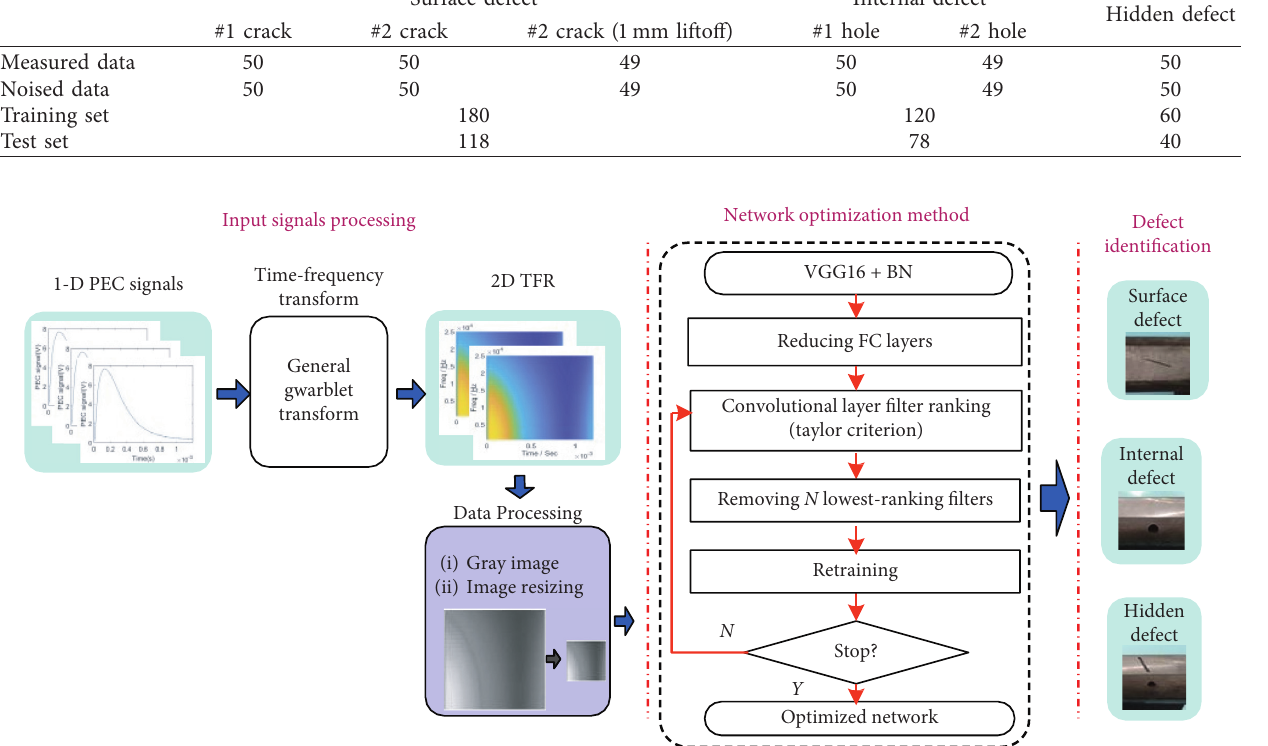
Figure 3: Technical pipeline of the proposed